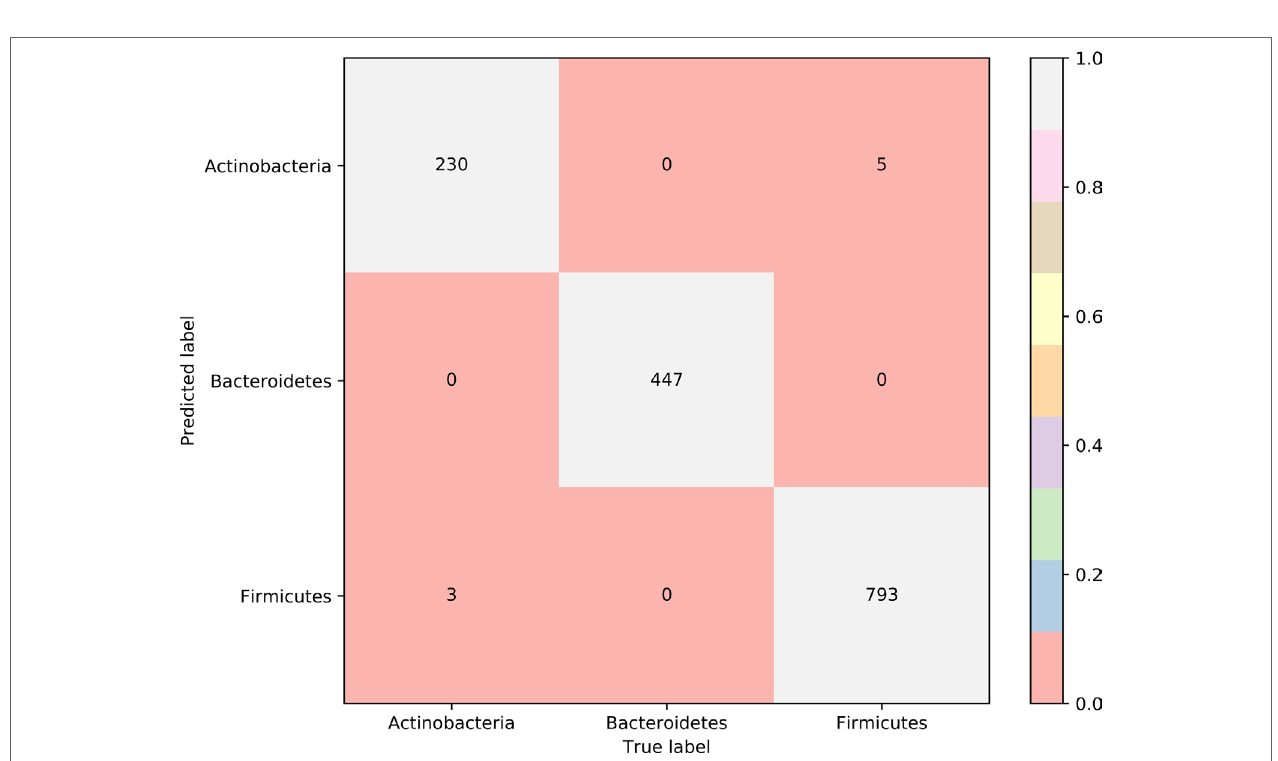
FIgURe 4 | Confusion matrix yielded by the RIPPER algorithm with top 25 features. The accuracy of Bacteroidetes reached 1.000, while those of two other phyla were higher than 0.970, indicating the high performance of RIPPER algorithm with top 25 features.